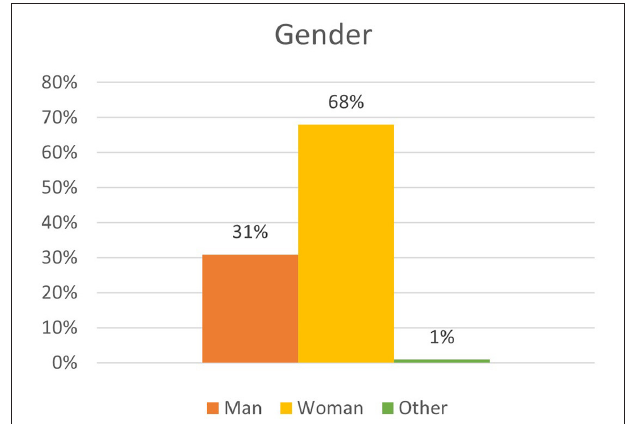
FIGURE 1 | Overview of distribution by gender.